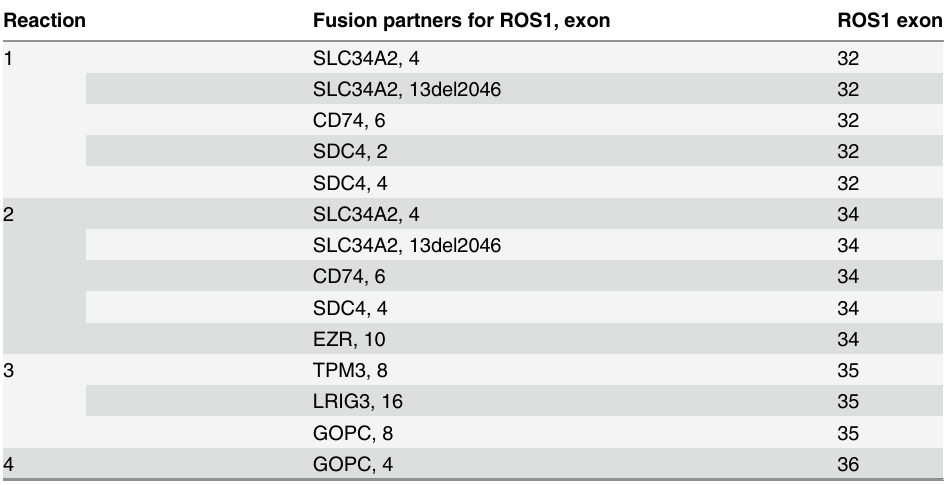
Table 1. The fusion patterns of ROS1 screened in this study.